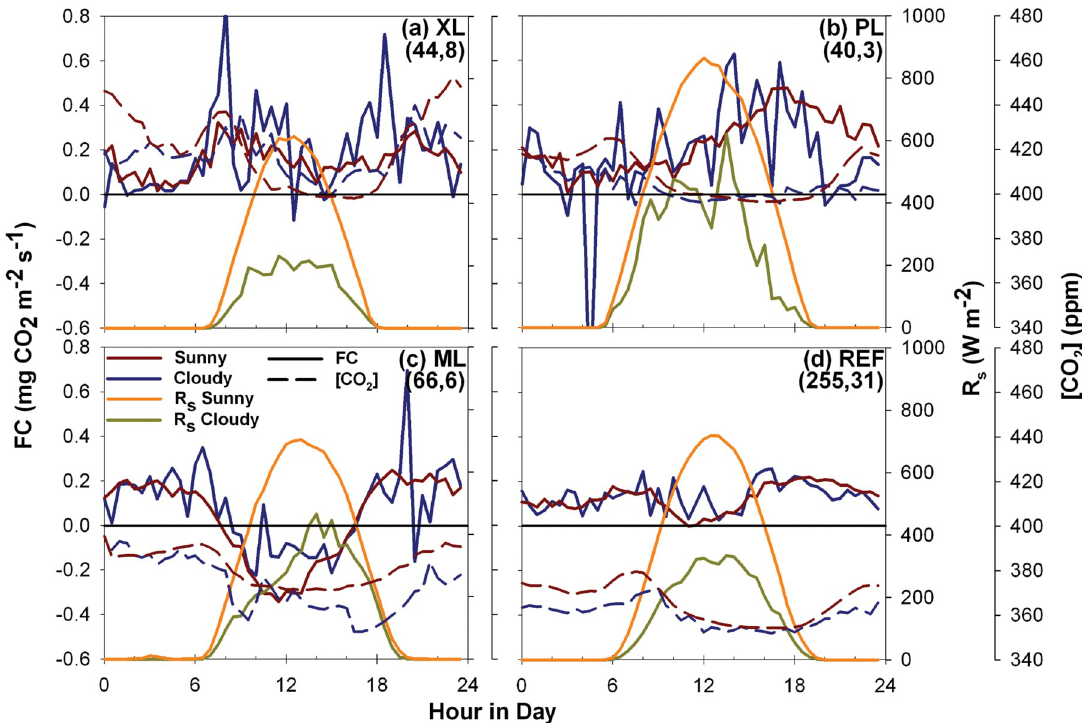
Fig 7. Diurnal averages of FC for sunny and cloudy days. Comparison of the average diurnal cycles of carbon dioxide flux for sunny and cloudy days for the (a) XL, (b) PL, (c) ML, and (d) REF sites, including average diurnal cycles of incoming solar radiation. Parentheses indicate the number of days in each category of sunny and cloudy for each site, respectively. Different sampling periods are specified in each plot.